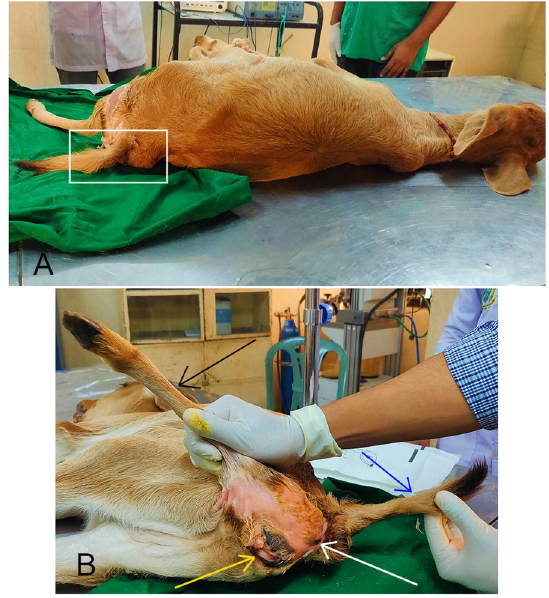
Fig. 2 Right lateral recumbency of the calf exhibiting the skeletal defect in the tail and exposing other collateral structures. A Short and contracted tail having a distinguishable S-shaped bending at the base dorsally to the rump (white rectangle). B Extension of the supernumerary limb (black arrow) exposing a loose attachment to skin and underneath tissues near to the anus (white arrow) and vulva (yellow arrow) distinct from the fairly rigid tail (blue